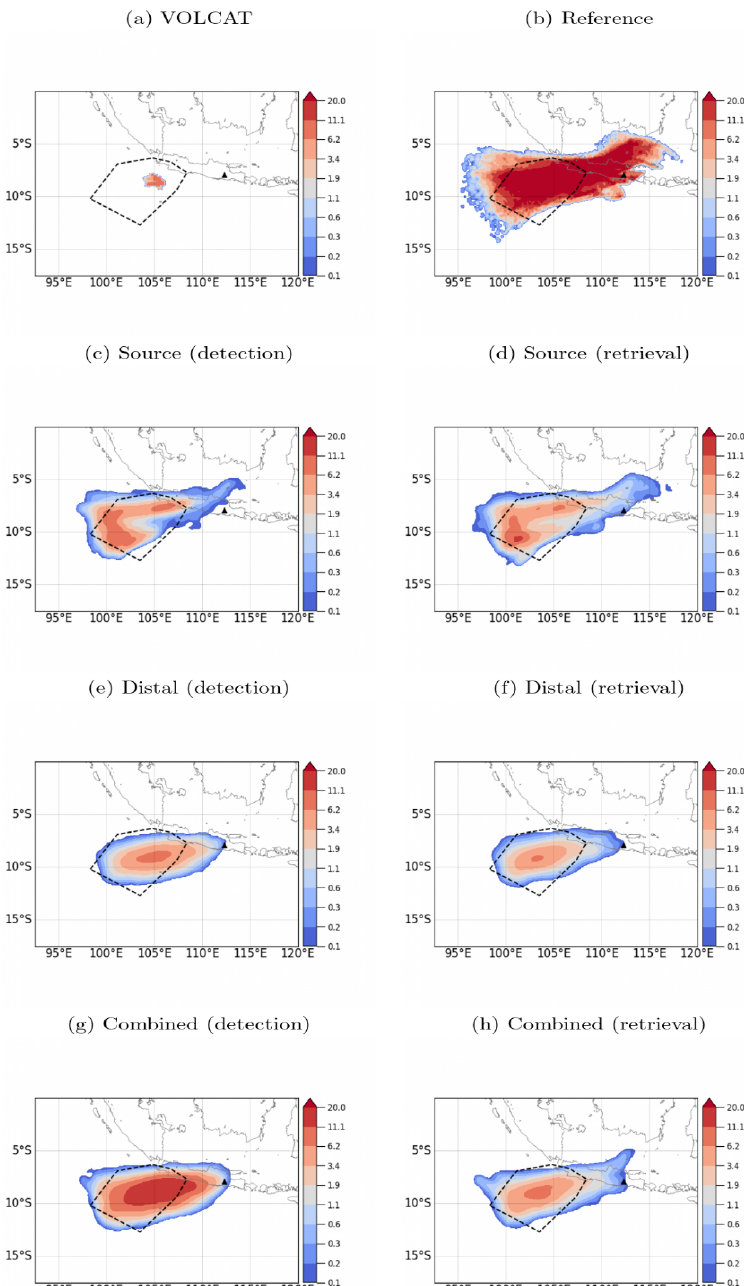
Figure 6. Mass load fields (in g/m 2 ) obtained for the 13 February 2014 Kelut eruption case study at 14/0830 UTC. The explanation for the different panels is the same as in Figure 5. The dashed lines represent the Darwin VAAC polygon at 14/0830 UTC.